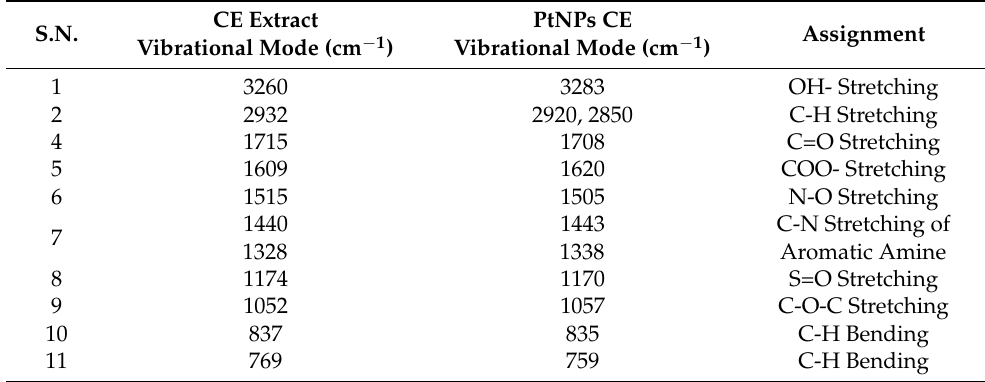
Table 1. Assignment of IR bands for CE extract and as-synthesized